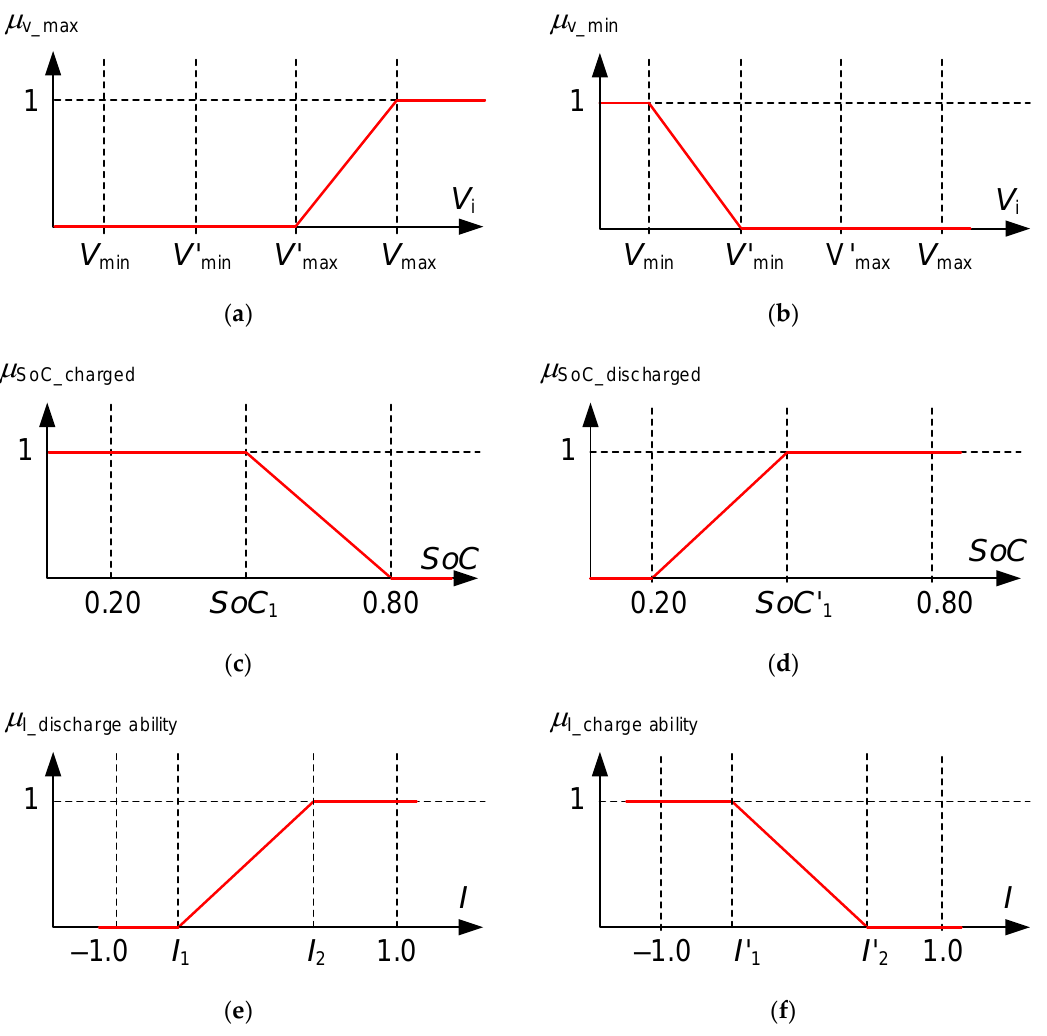
Figure 4. The membership functions for individual input. ( a ) Voltage value is determined as ‘too low’; ( b ) voltage value is determined as ‘too high’; ( c ) SoC of the ESU is determined as ‘charged’; ( d ) SoC of the ESU is determined as ‘discharged’; ( e ) power line has ‘discharge ability’; ( f ) power line has ‘charge ability’. Membership functions for reference active power P ref and reference reactive power Q ref are depicted in Figure